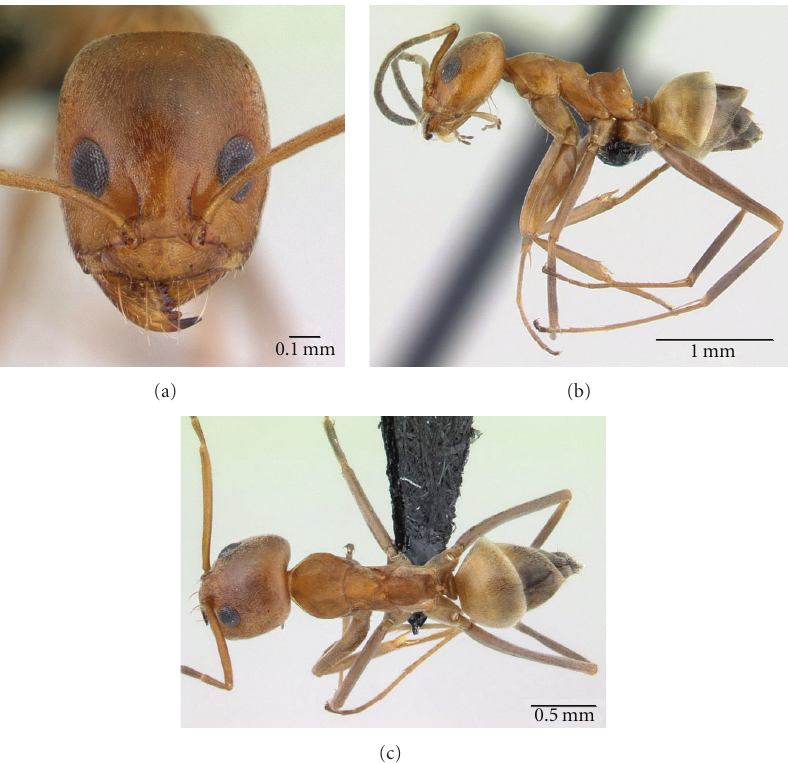
Figure 3: Dorymyrmex biconis worker. (a) Head in full-face view; (b) body in lateral view; (c) body in dorsal view (CASENT0179483). Pictures and labels of localities of each photographed specimen are available at